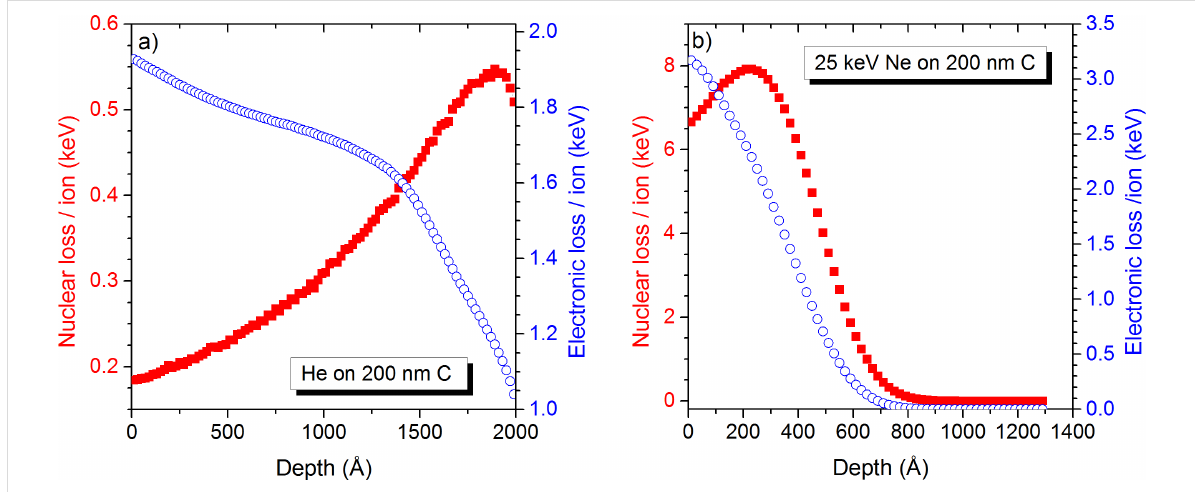
Figure 4: Nuclear and electronic energy loss as a function of sample thickness for a) He + and b) Ne + irradiation of suspended